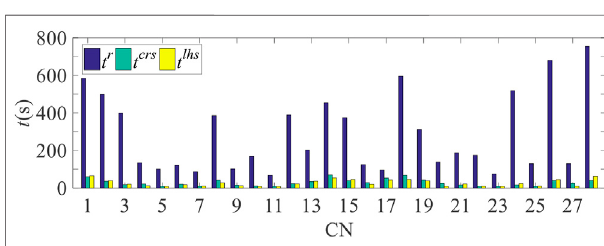
FIGURE 5 | Running time of different sampling methods.